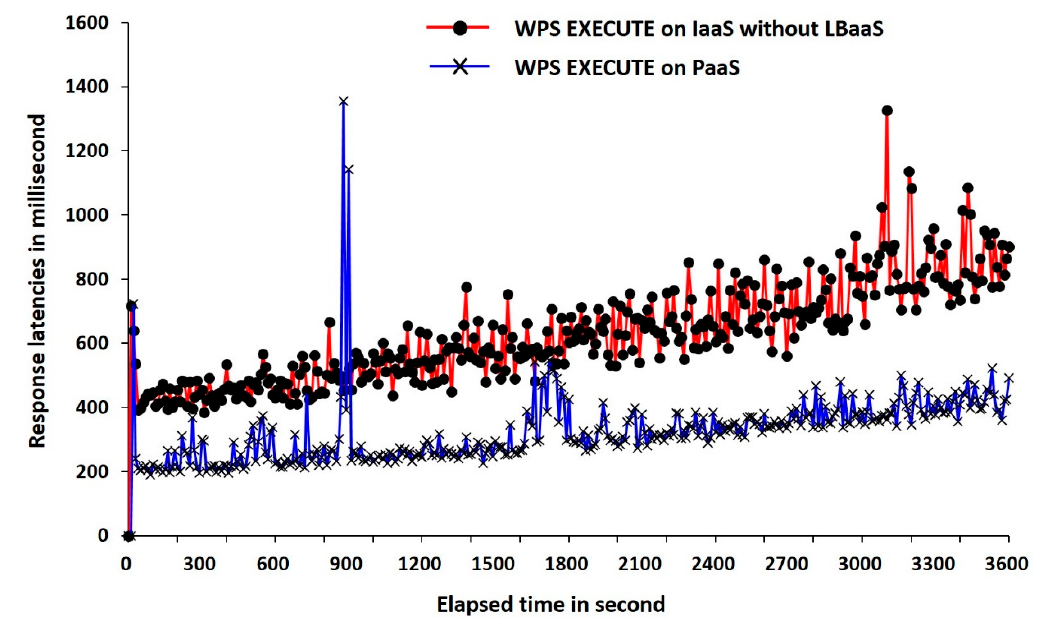
Figure 5. Performance test result for OGC WPS 2.0, executing an operation, with an edge detection algorithm, on PaaS and IaaS without LBaaS: a case of 500 threads for 3600 s.